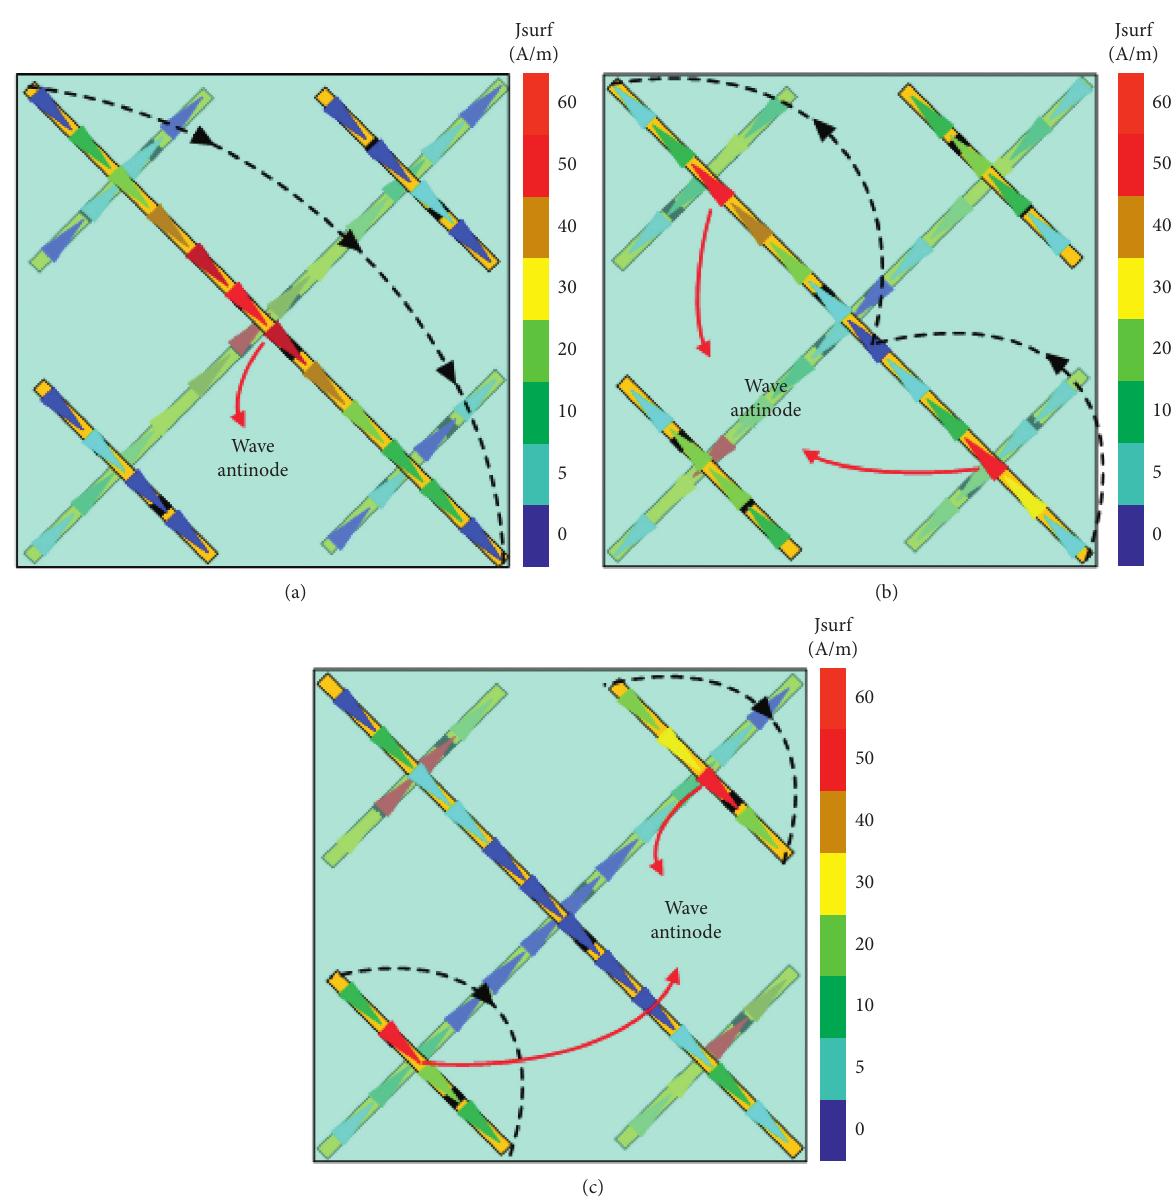
Figure 5: Simulated current distributions of the proposed absorber at three resonant frequencies of (a) f � and (c) f 3